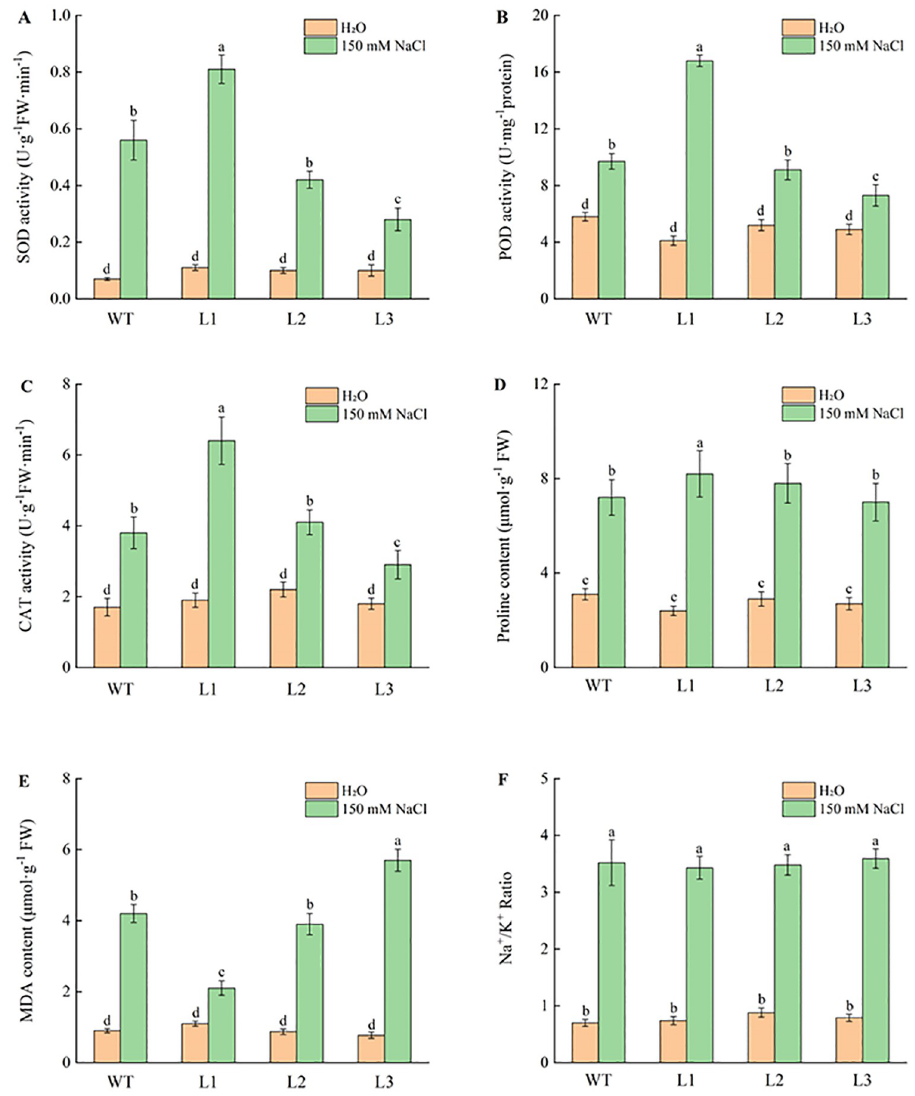
Fig 6. Comparison of antioxidative enzymes (SOD, POD, CAT), membrane lipid peroxidation index (MDA), osmolyte (proline), and Na + /K + ratio among wild type and transformants under salt stress. Values are mean ± standard deviation followed by the same letter did not significantly differences at P � 0.05 according to least significant difference test.